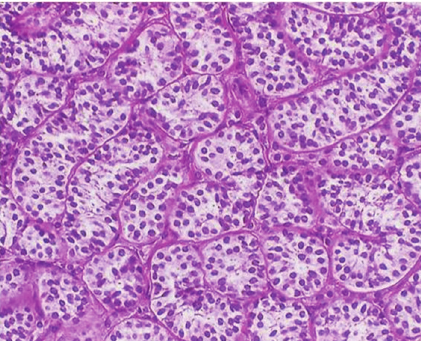
Figure 3: Microscopy: Sertoli cell tumor, with Sertoli cell tubules under high magnification (HE staining, magnification